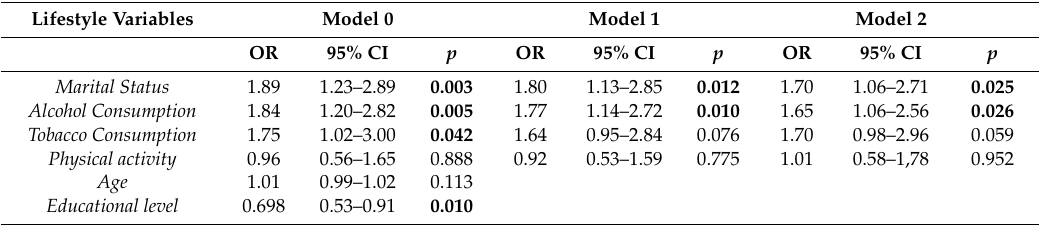
Table 2. Logistic regression models for the association between The Conformity to Feminine Norms Inventor (CFNI) and lifestyle